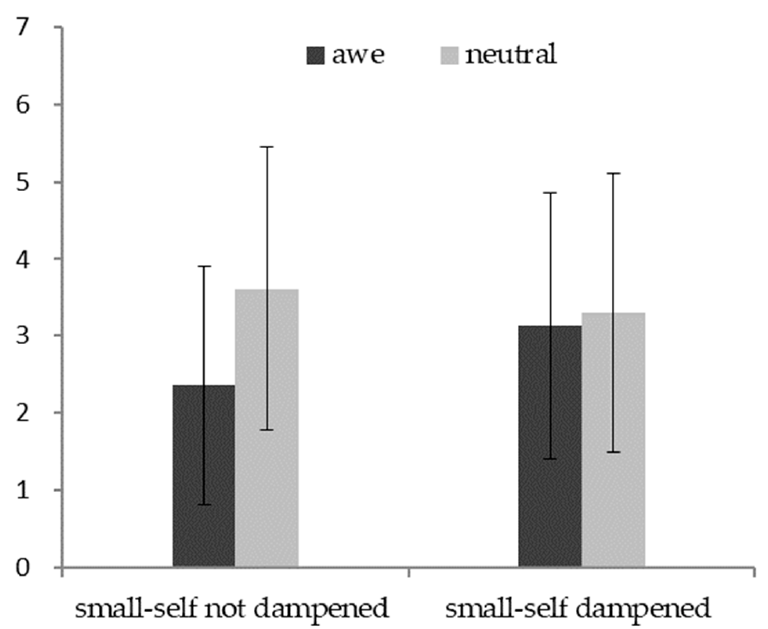
Figure 4. The interaction effect of awe (vs. neutral) and small-self (not dampened vs. dampened) on negative emotions arising from self-threat.